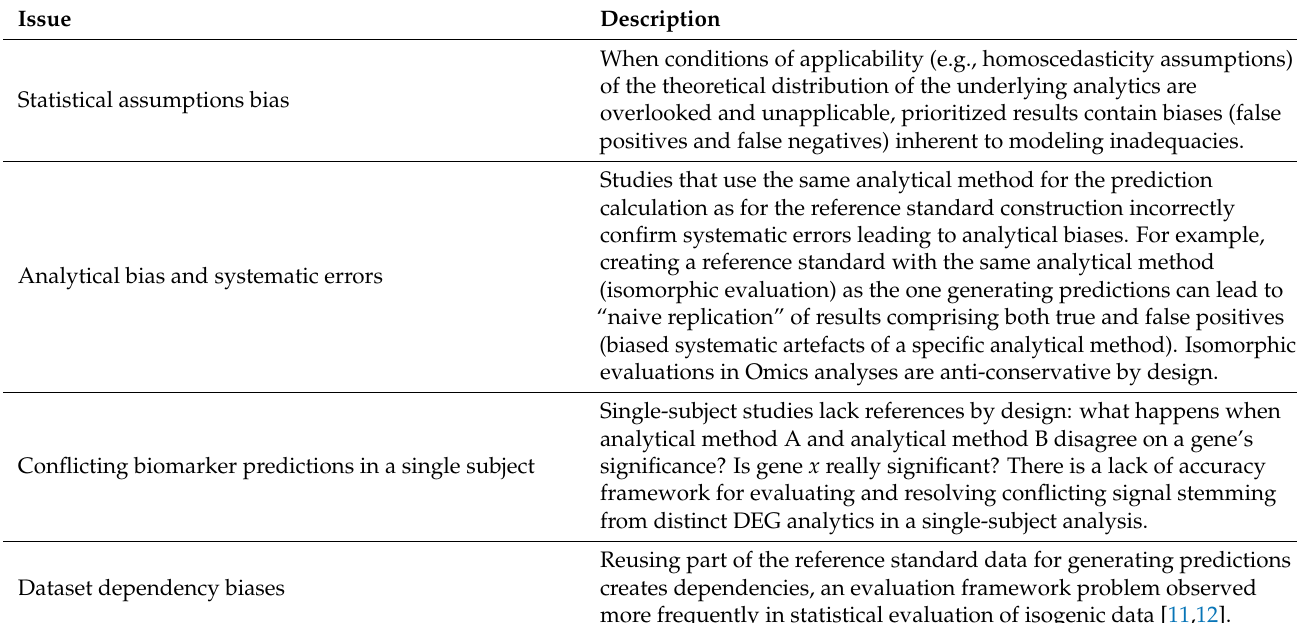
Table 1. Current limitations with biased gold standards in transcriptomic gene expression in single-subject